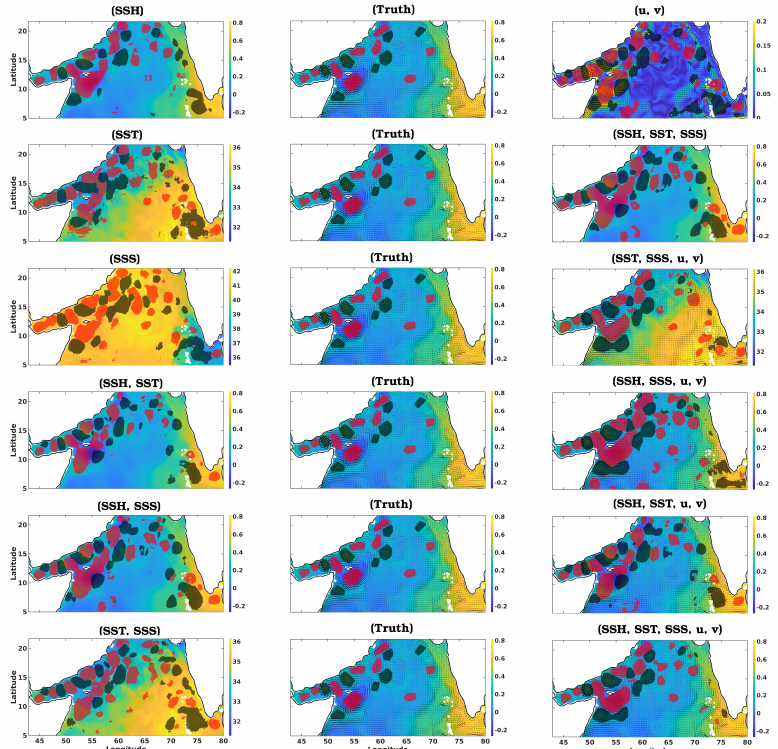
Figure 5. Illustration of the neural network predictions ( left and right columns) for DNNs trained using the input variables indicated by the titles of each subplot, along with the true human labels ( center column). We used the same input field for all the predictions, and the same truth is repeated in each row to make the comparison easier for each case. Here, cyclonic eddies are colored red and the anticyclonic eddies are colored black. Note that the background and the color bars correspond to the first ocean − surface variable indicated by the subfigure title. The velocity vector field is overlaid on top of the scalar field whenever